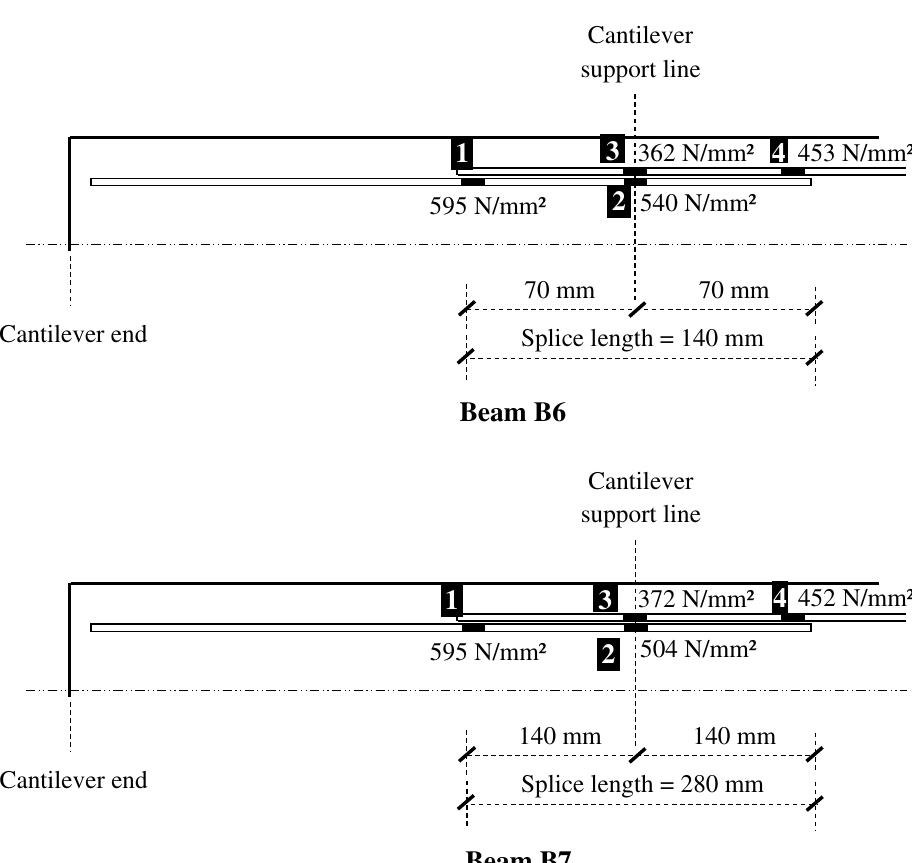
Fig. 16 Ultimate steel stress values calculated from steel strains at strain gauges’ locations shown in Fig. 2 (Shear links omitted for clarity) Not to scale